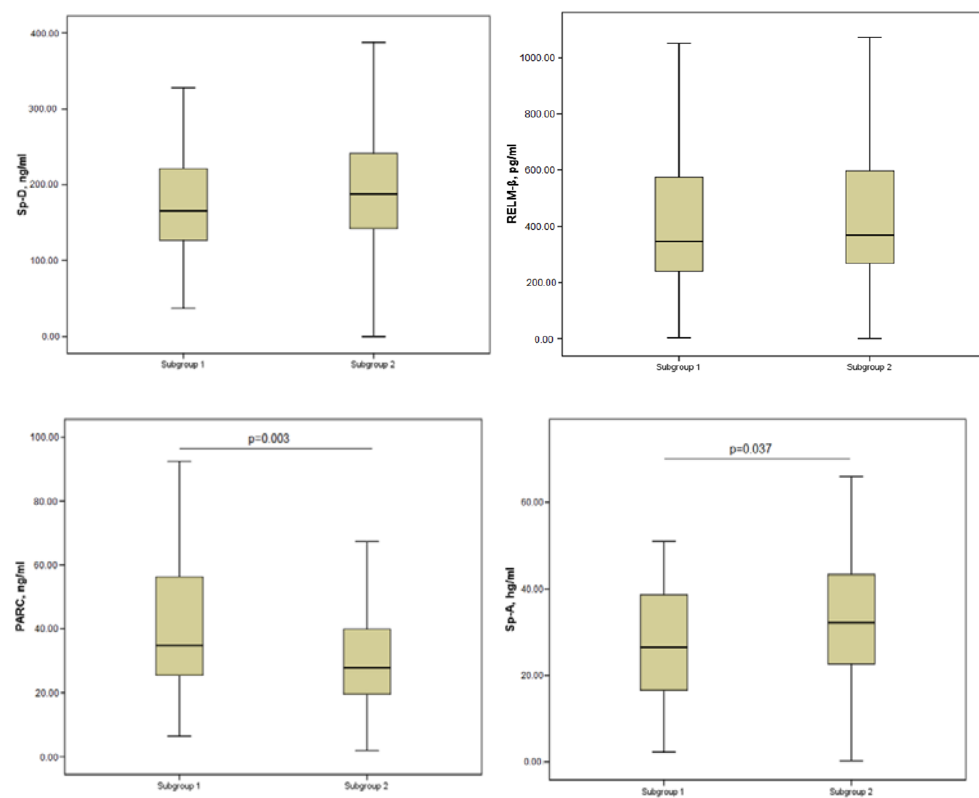
Figure 1. Level of the studied biochemical parameters in patients with chronic bronchitis with and without abdominal obesity.